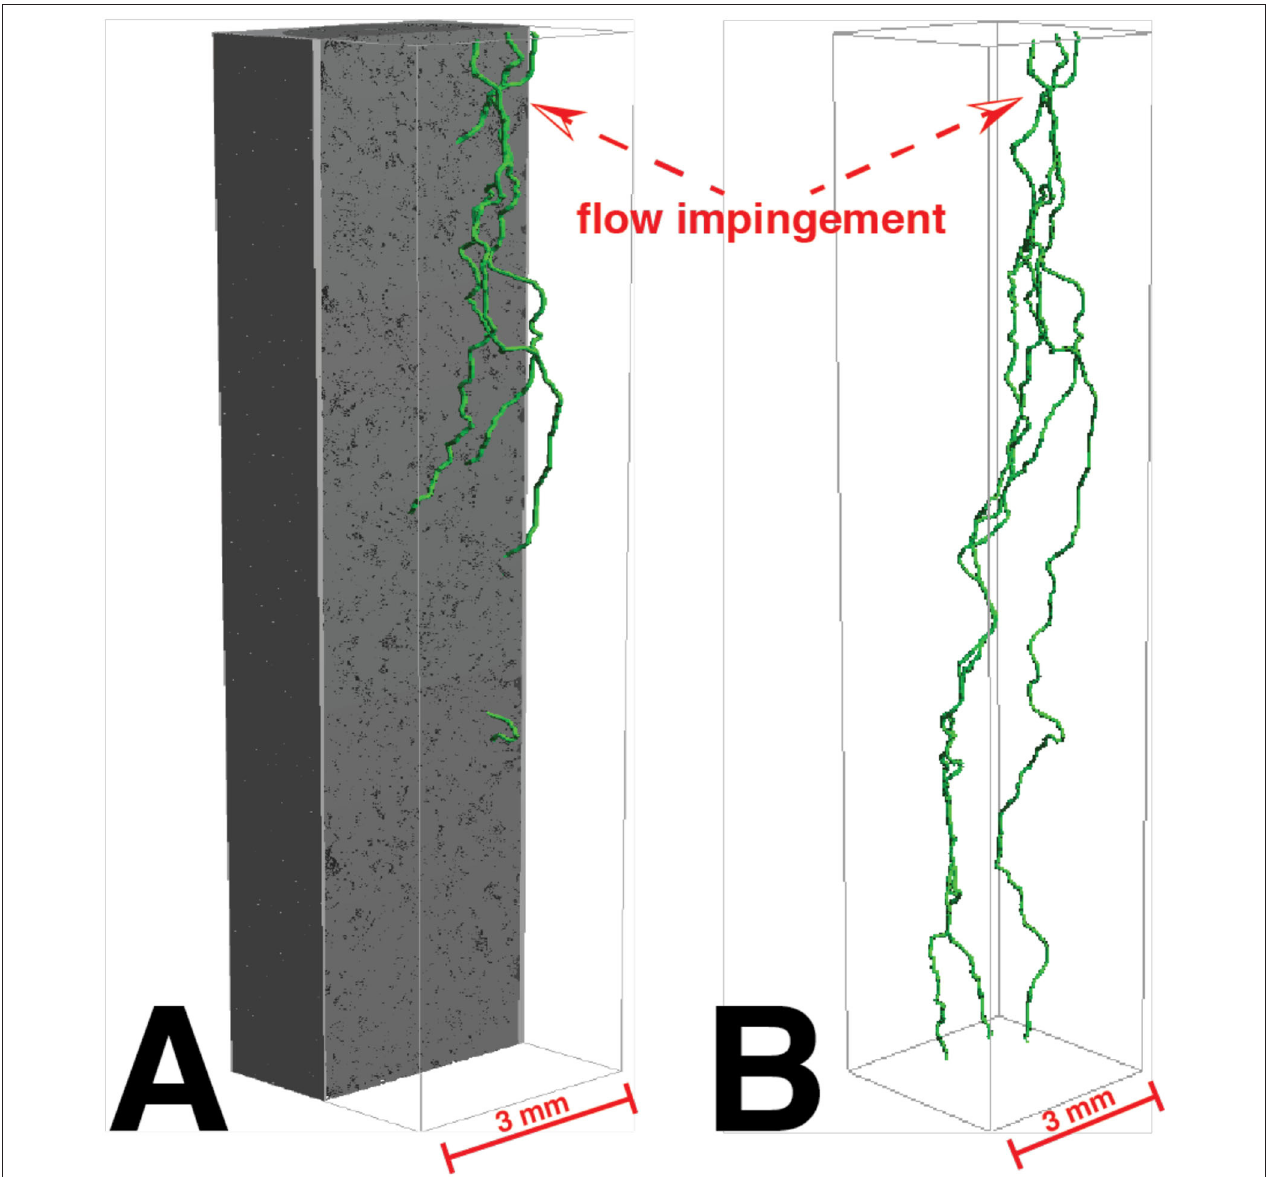
FIGURE 14 | The three widest percolation paths through the core shown in green with the rock shown in gray (A) and the rock transparent (B) .